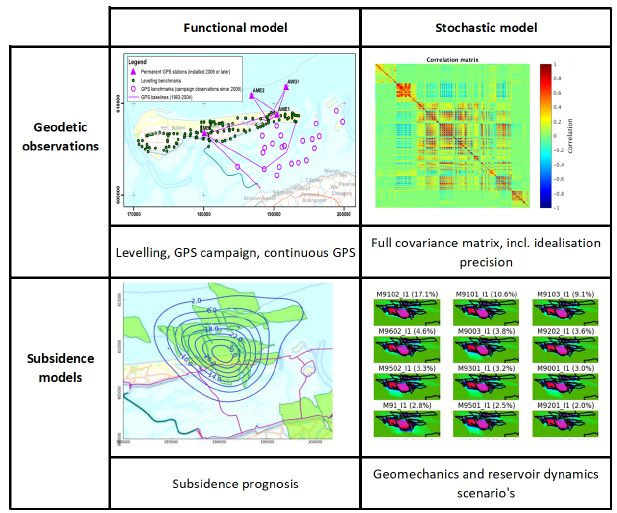
Figure 5. Four quadrant summary of the LTS elements. Both mod- els and measurements are assigned a functional and a stochastic de- scription. The LTS study aims at confronting these. Images from © NAM; source: NAM